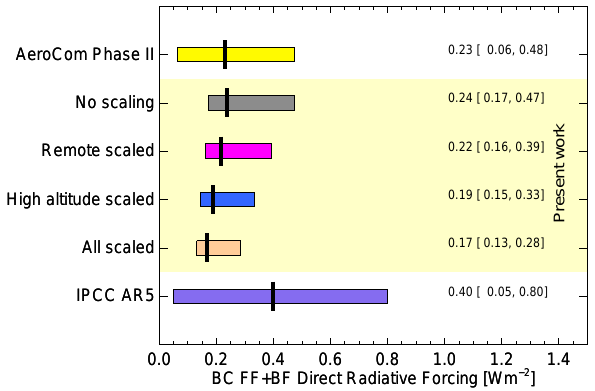
Figure 4. Model median and 5–95% range for BC FF + BF forc- ing, for 1750–2010, with various scalings applied. The yellow bar shows the AeroCom Phase II result (Myhre et al., 2013b). The grey bar shows unscaled values from the present work, then with remote scaling (pink) and high-altitude scaling (blue) applied. The khaki bar shows the lower limit on BC FF + BF forcing from the present work, with both scalings applied. Below we compare with the recent estimate in IPCC WG1’s